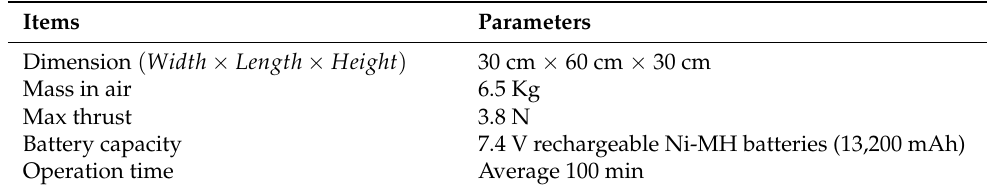
Figure 2. Mechanical structure of the vector-propulsion mechanism. Table 1. The technical specifications of the